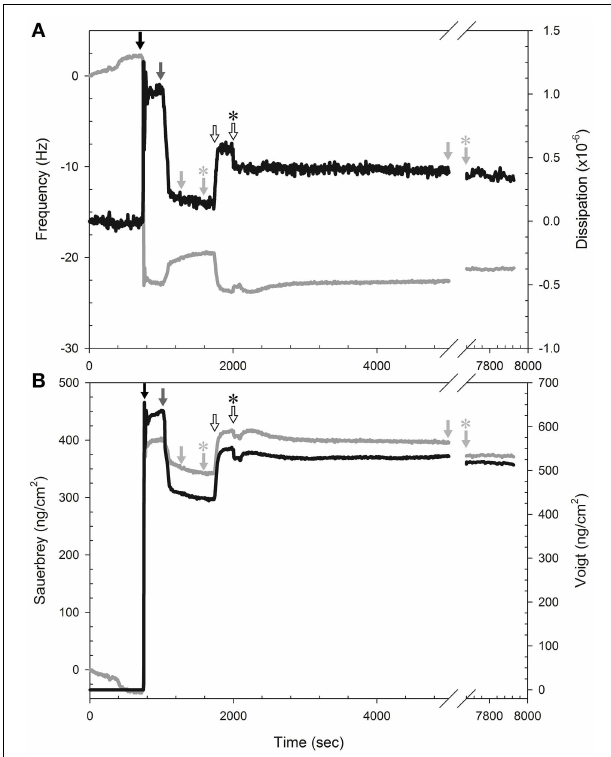
FIGURE 9 | Isoeugenol binds reversible to SLB and increases membrane hydration. (A) Representative measurement of frequency (gray line) and dissipation (black line) changes at the 9th harmonic of a DOPG:DOPC (20:80) membrane at 37 ◦ C. To form SLBs we introduced lipid vesicles (black arrow) in MES-buffer (pH 6.0), followed by pure MES-buffer (pH 6.0) with 20mM CaCl 2 (dark gray arrow). All rinsing steps was performed with fresh MES-buffer without CaCl 2 (pH 6.0, light gray arrow) to remove excess lipid, and the flow was stopped momentarily (light gray arrow with asterisk). Isoeugenol was injected at a final concentration of 0.03mg/mL (hollow arrow) until chamber content was exchanged, and the flow was stopped (hollow arrow with asterisk) until treatment had lasted 60min, followed by buffer-rinse for 45min before the rinsing was stopped (light gray arrow with asterisk). (B) Modeling of area mass changes during SLB formation and isoeugenol exposure using Sauerbrey (gray line) and one-layer Voigt (black